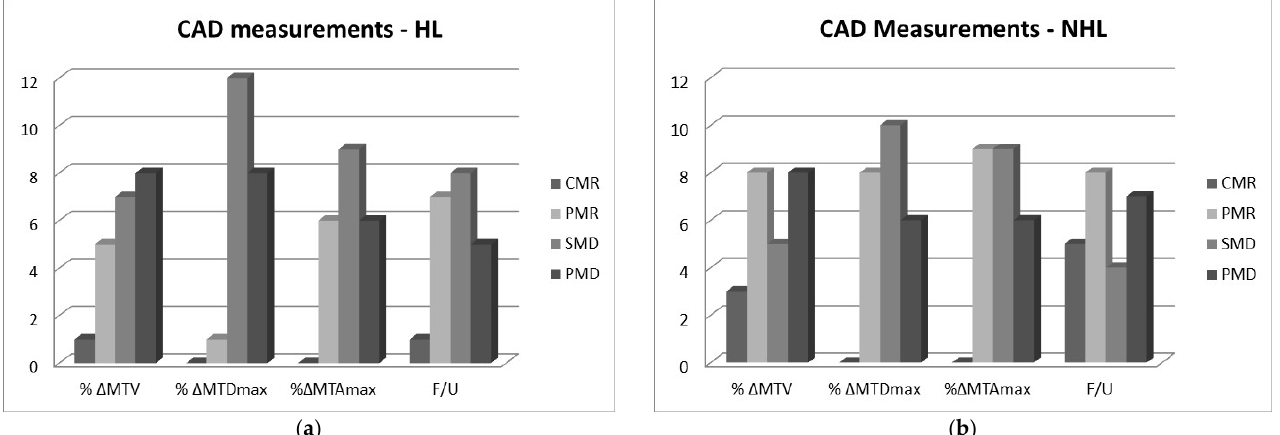
Figure 2. Distribution of the number of RECIL classes estimated from CAD’s measurements of relative percent changes in volume, maximum diameter, and maximum area, i.e., % ∆ MTV, % ∆ MTDmax, % ∆ MTAmax for the ( a ) HL and ( b ) the NHL cases. The follow-up (F/U) clinical classification of the patients is also included.